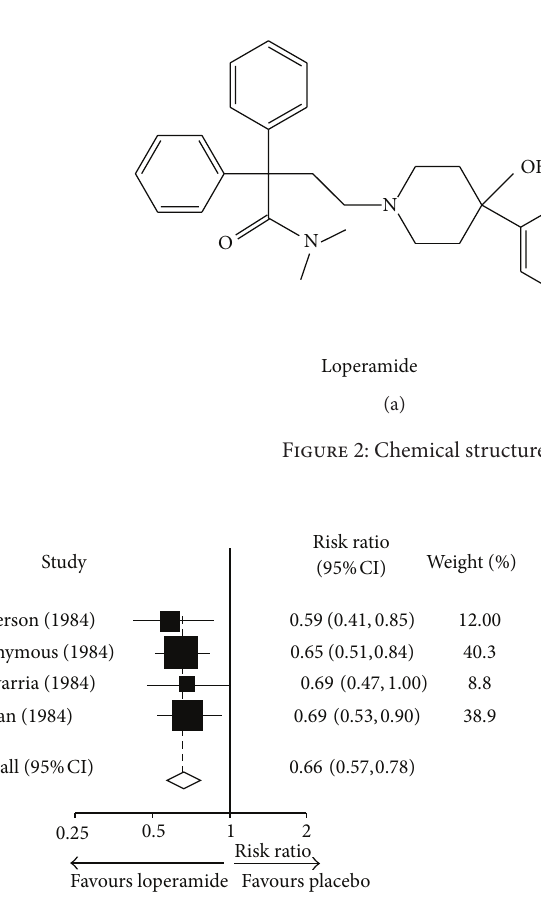
Figure 3: Efficacy of loperamide: meta-analysis of persistence of diarrhoea at 24 h in placebo-controlled clinical trials of loperamide in the treatment of acute diarrhoea in children. The 𝑥 -axis uses the log scale. Risk ratios were calculated using a random-effects model. Reproduced with permission from Li et al. 2007